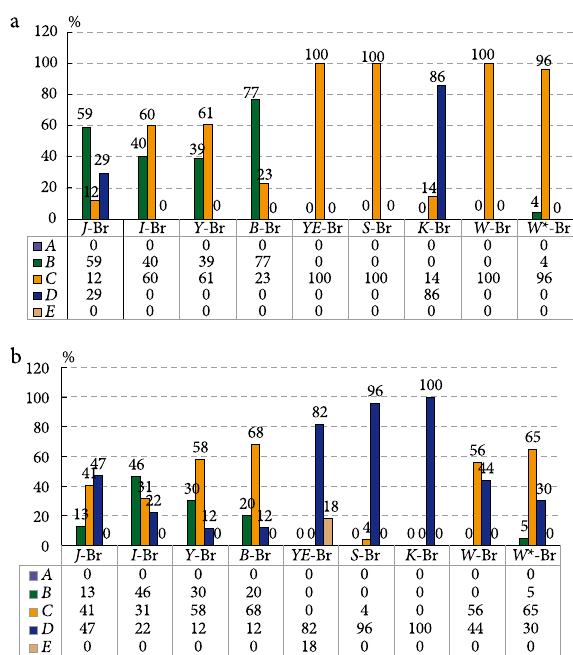
Fig. 7. Perception criteria of vibration: a – displacement; b –